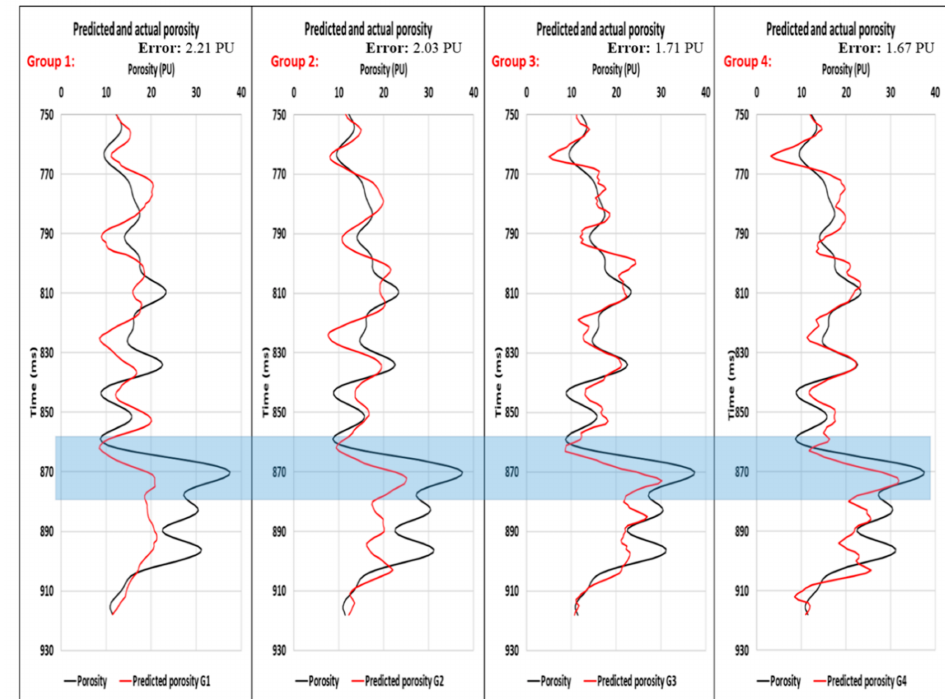
Figure 9. Comparison of resulting predicted log ( red ) and actual porosity log filtered to 100 Hz ( black ) for a well not used in the training process using the different attribute groups. Error is the mean absolute error over the prediction interval. The blue rectangle highlights the main reservoir unit. A small time–depth error at the reservoir level is more obvious for Groups 3 and 4.